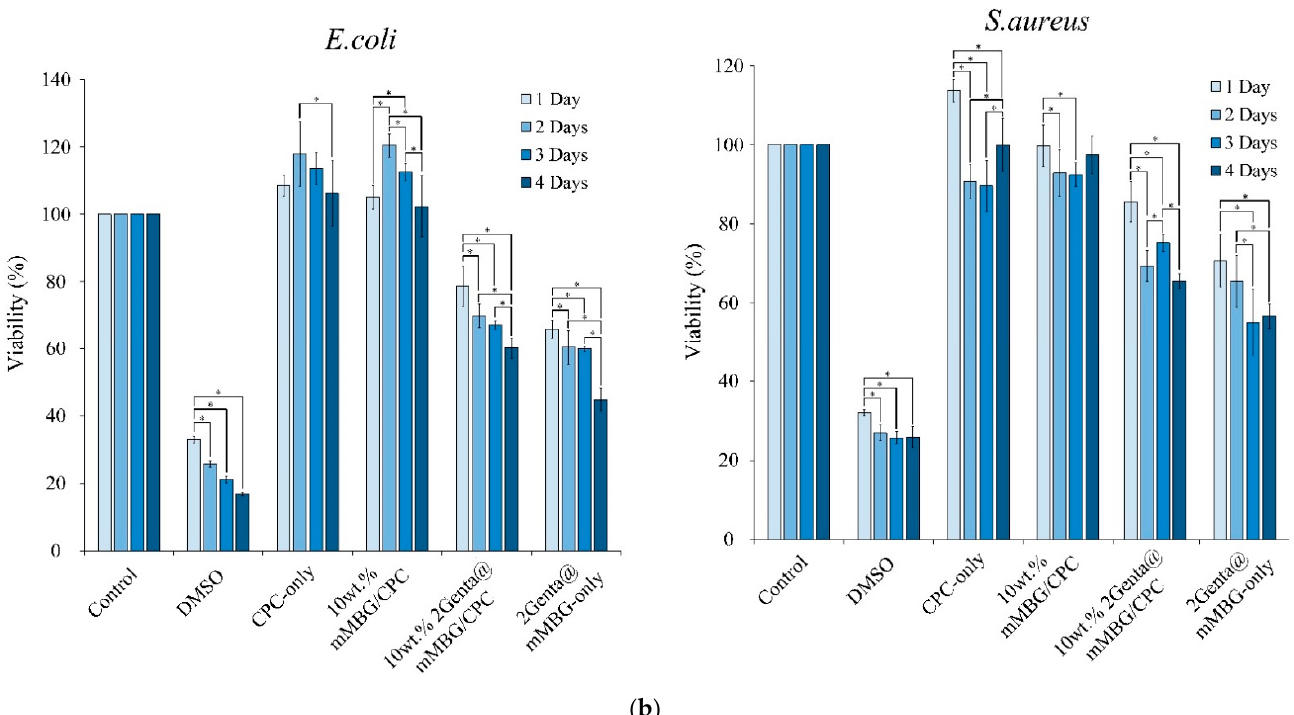
Figure 7. Antibacterial activities of Genta-loaded mMBG (2Genta@mMBG), CPC-only, 10 wt.% mMBG/CPC, and 10wt.% 2Genta@mMBG/CPC composite bone cements against S. aureus and E. coli for ( a ) a zone of inhibition of 1 day and ( b ) quantitative analysis for 1–4 days ( n = 3; * indicates significantly different p < 0.05).